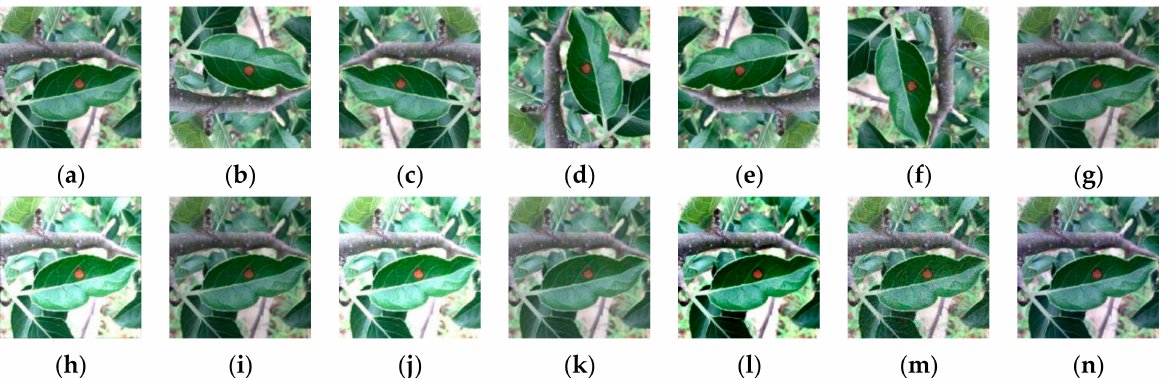
Figure 2. The data augmentation examples of training set: ( a ) Original image; ( b ) Vertical mirroring; ( c ) Horizontal mirroring; ( d ) Rotating 90 ◦ ; ( e ) Rotating 180 ◦ ; ( f ) Rotating 270 ◦ ; ( g ) Weak sharpening; ( h ) Strong sharpening; ( i ) Weak light; ( j ) Strong light; ( k ) Weak contrast; ( l ) Strong contrast; ( m ) Gaussian noise; ( n ) PCA